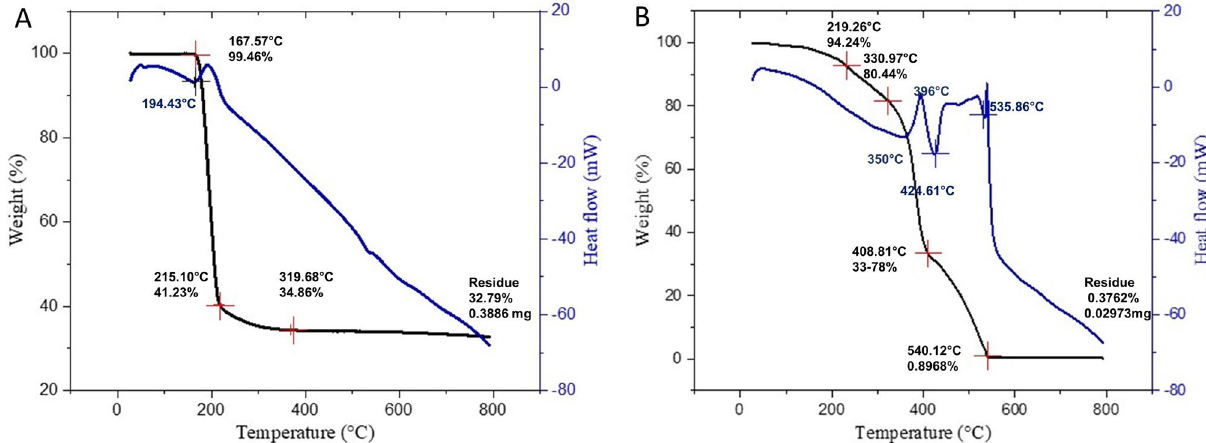
Figure 4. Thermal gravimetry–differential scanning calorimetry analysis of ( A ) pure sample of 2-methoxy-4- vinylphenol (2M4VP) and ( B ) cellulose acetate phthalate nano-formulation of 2M4VP (CAP-2M4VP) showing greater thermal stability of the polymeric nanoparticles than the pure drug 2M4VP.